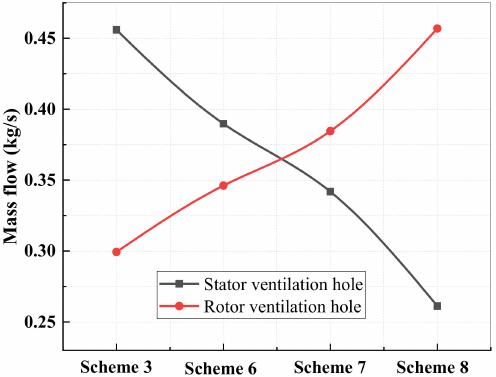
Figure 15. Ventilation rate comparison under the scheme with varying cross-sectional diameter.